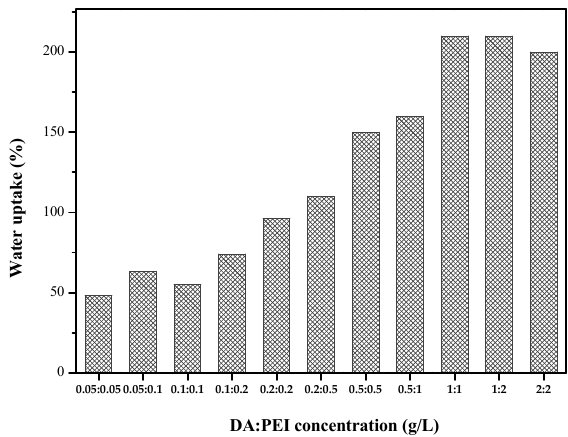
/ PEI-modified PSF membranes. Figure 2. Water uptake of the DA/PEI-modified PSF membranes. Figure 2. Water uptake of the DA Figure 2. Water uptake of the DA/PEI-modified PSF membranes.